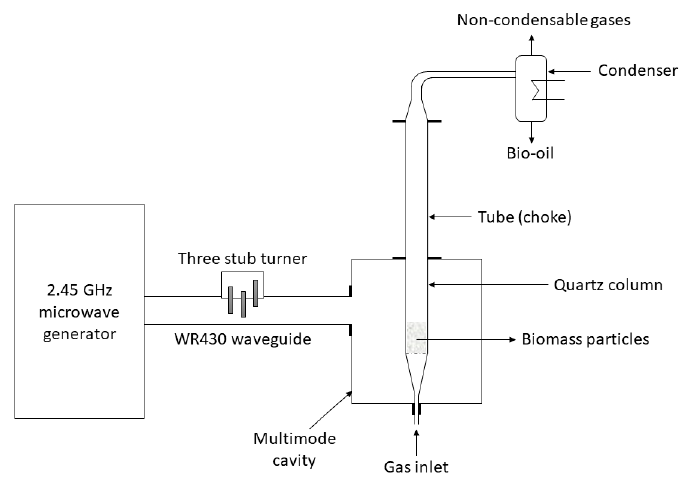
Figure 7. MAP FBR used by Adam et al. (Adapted from [69]).